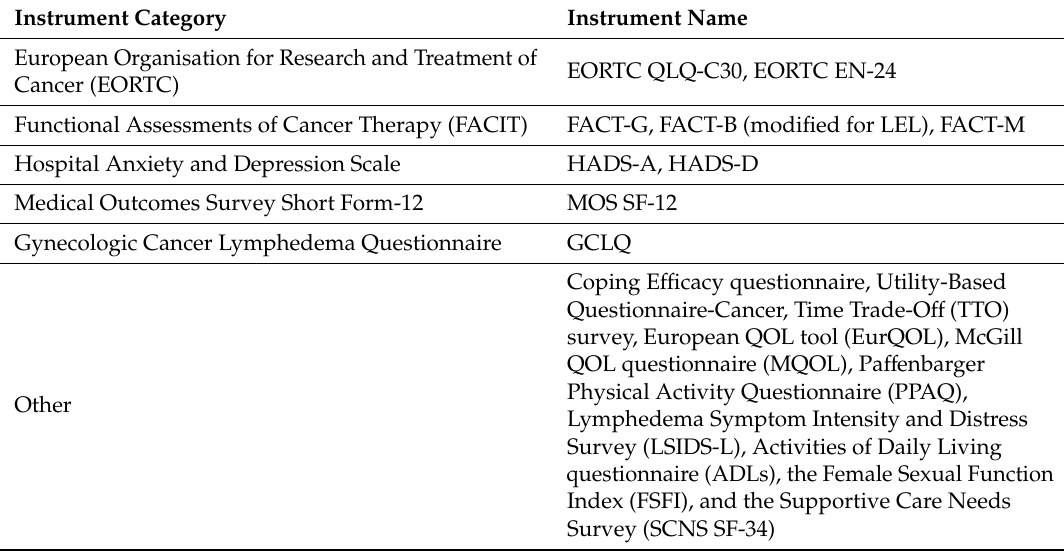
Table A3. All measures used to assess psychosocial well-being and / or QOL within the reviewed